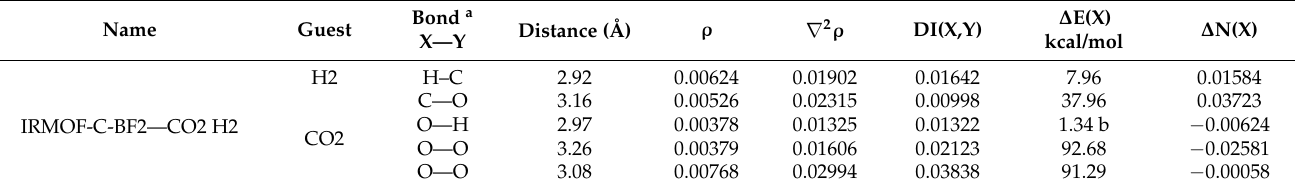
Table 6. Topological parameters of the BCP of bond in adsorption configurations of guest molecules (CO 2 and H 2 ) on IRMOF-C-BF 2 —CO 2 H 2 .